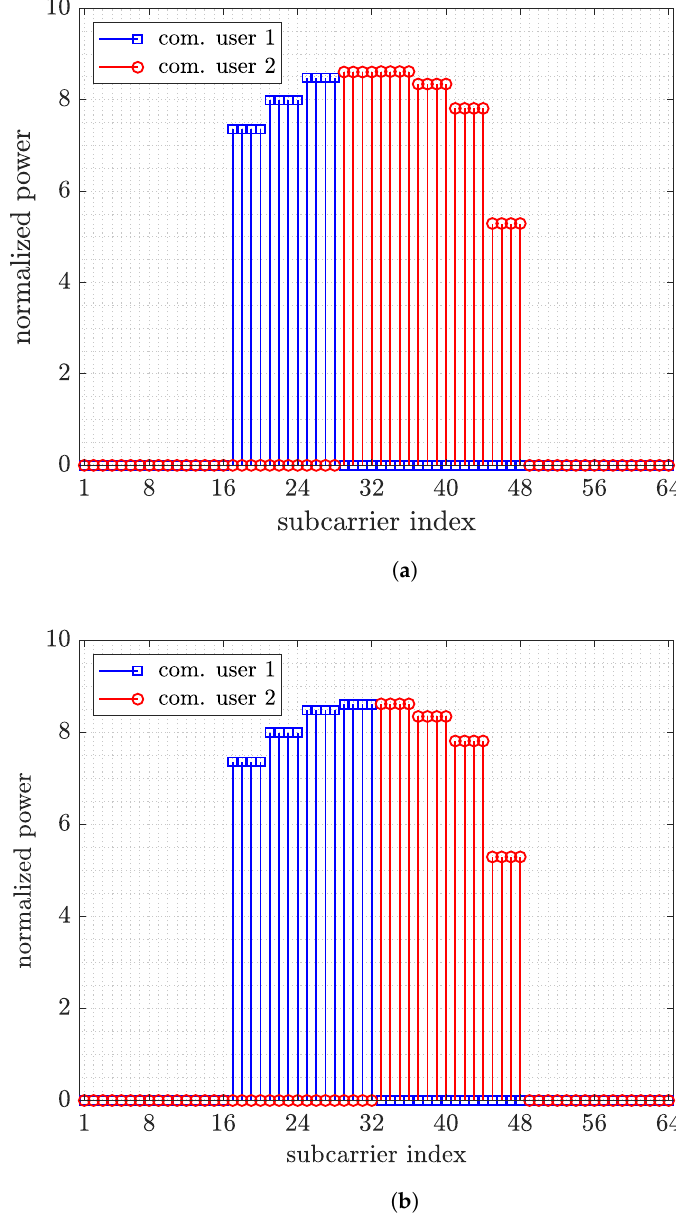
Figure 6. Radar-greedy design with chunk subcarrier allocation ( I ( y rad ; h | s ) = 31.30, I ( y com,1 ; g 1 | s ) = 13.08, I ( y com,1 ; g 2 | s ) = 15.87). ( a ) Overall communication MI maximization ( I ( y rad ; h | s ) = 31.30, I ( y com,1 ; g 1 | s ) = 12.86, I ( y com,1 ; g 2 | s ) = 17.46). ( b ) Worst-case communi- cation MI